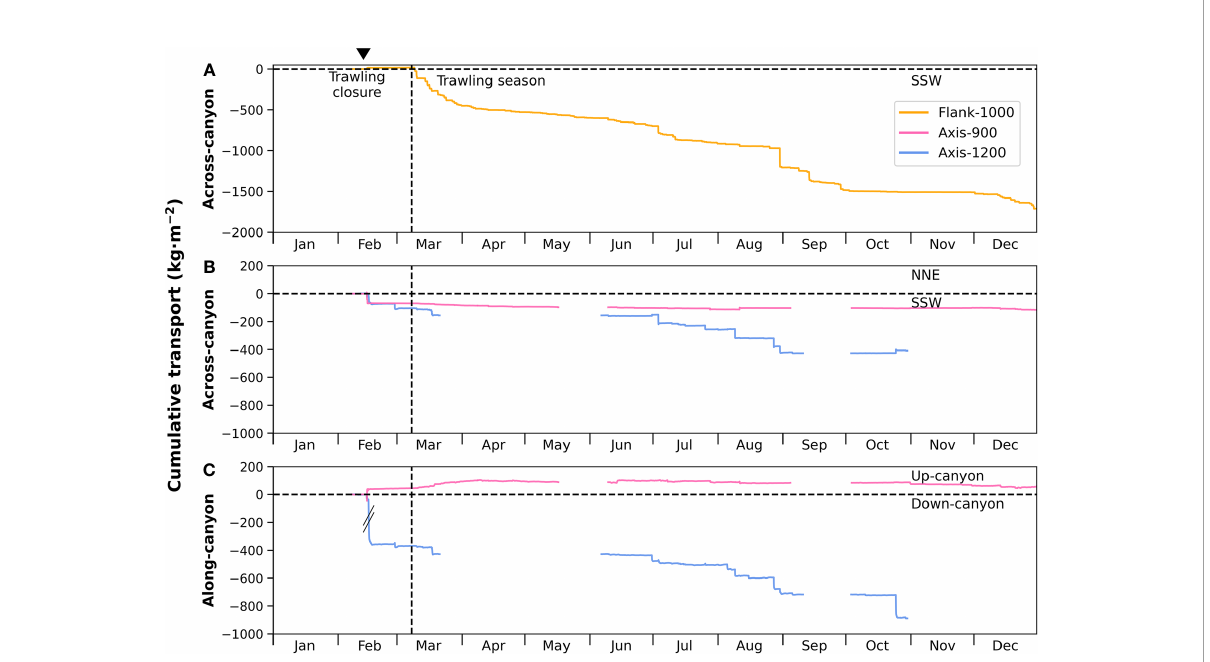
FIGURE 9 Time series of cumulative sediment transport at all moorings: (A) at the Flank-1000 mooring in the across-canyon direction (10 mab), (B) at Axis-900 and Axis-1200 in the across-canyon direction (5 mab) and (C) in the along-canyon direction (5 mab). Cumulative sediment transport for Axis-900 and Axis-1200 are highly underestimated due to their incomplete timeseries and the maximum data acquisition of the Axis-1200 turbidimeter during the fi rst deployment (Figure 5). Note the different axes for the Flank-1000 cumulative sediment transport in comparison to the across-canyon and along-canyon transport of Axis-900 and Axis-1200. The inverted triangle on top indicates the occurrence of a dense shelf water cascading event.